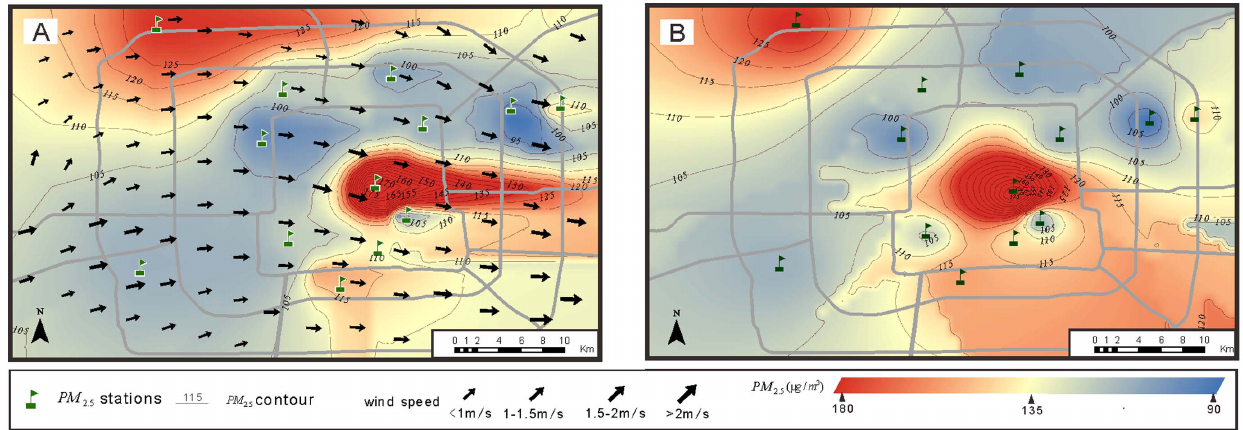
Figure 4. Comparison between the daily PM 2.5 (May 21 st ) estimations obtained using IDW based on the SWPD and the Euclidean distance. (A)Interpolation results obtained using IDWS. (B) Interpolation results obtained using